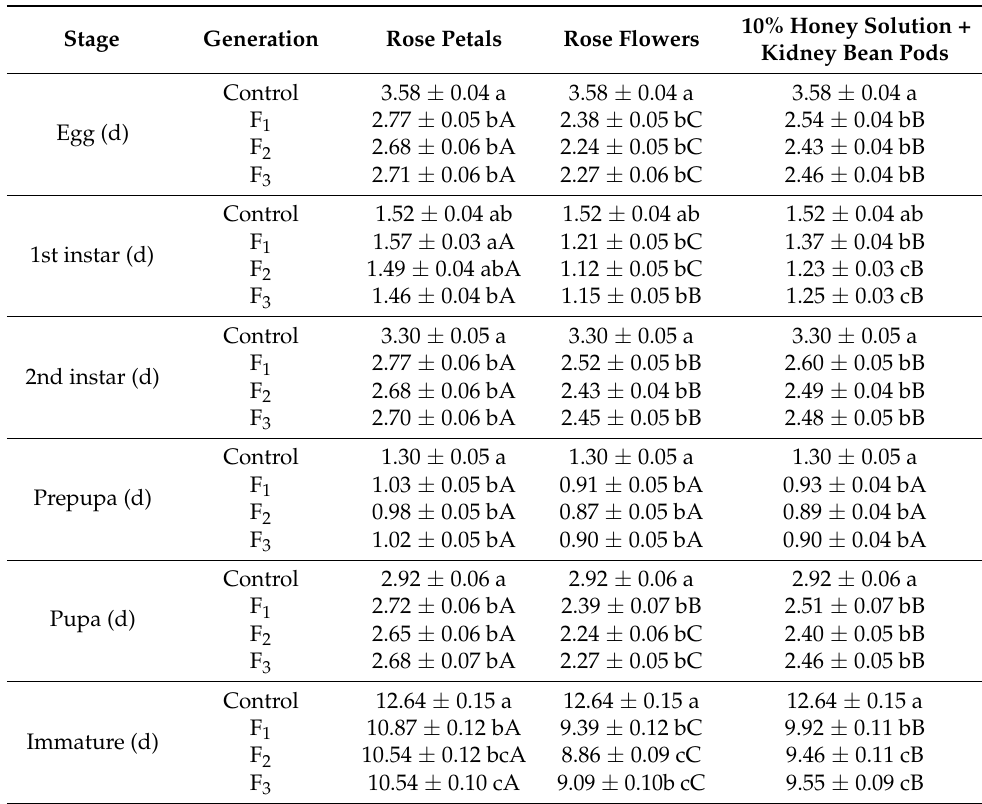
Table 1. Effect of different foods on F. occidentalis